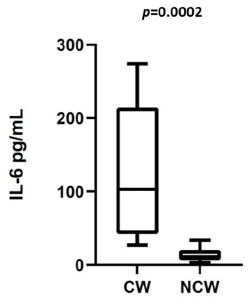
Figure 3. IL-6 levels at admission between 15 CHD patients in the clinical-worsening group (CW) vs. 11 CHD patients in the non-clinical-worsening group (NCW). Table 3. Simple logistic regression analysis (A) and multiple logistic regression model (B) to predict clinical worsening in hemodialysis patients with SARS-CoV-2